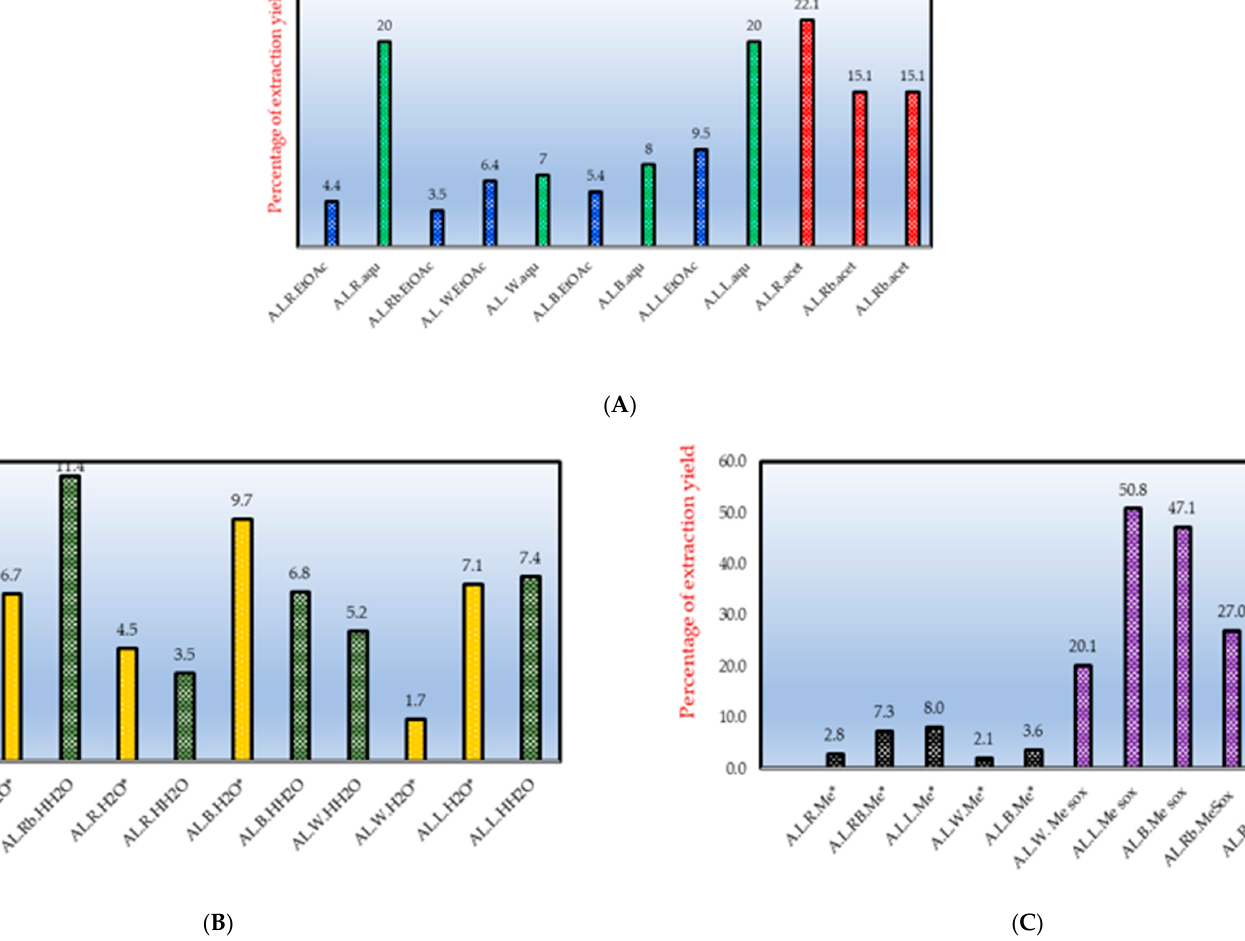
Figure 6. Percentage of extraction yield. ( A ) ethyl acetate (EtOAc), aqueous (aqu), and acetone (acet) in sequential extraction; ( B ) hot (HH 2 O) and cold water (H 2 O*) extraction; and ( C ) methanol extraction, Soxhlet extraction (Me sox), and cold methanol extraction (Me*); (A.L.), Anogeissus leiocarpa ; (Rb), root bark; (R), root; (W), stem wood; (B), stem bark; and (L), leaf. Extracts obtained using the same solvent are marked with the same color or